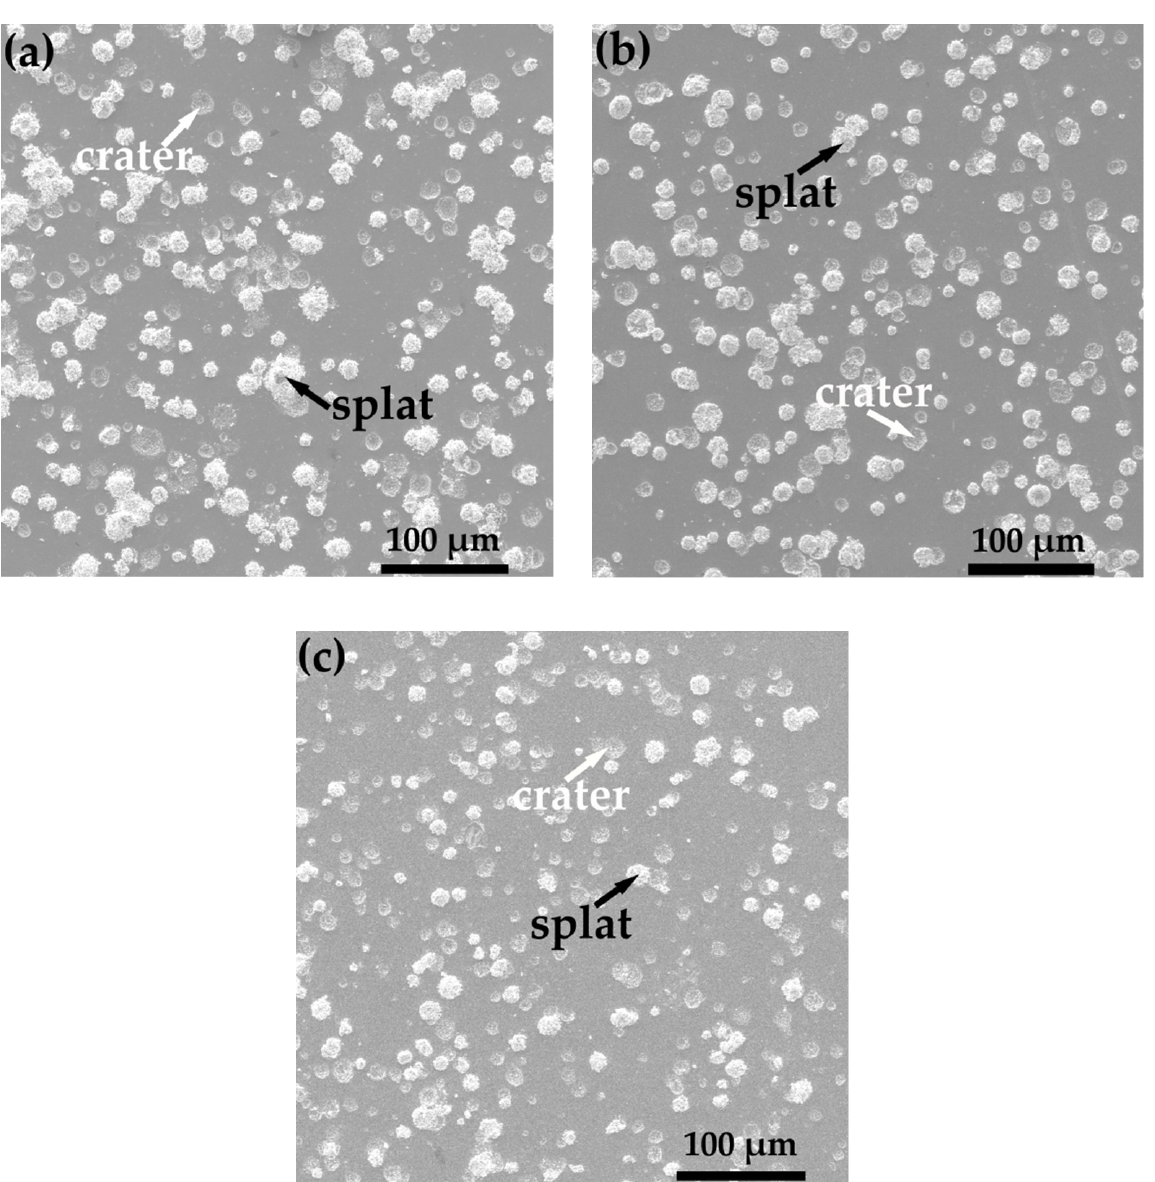
Figure 14. Morphologies of WC-17Co particles deposited onto Q235 steel substrate in various spraying ways ( a ) HVOF, ( b ) WS, ( c ) CS.